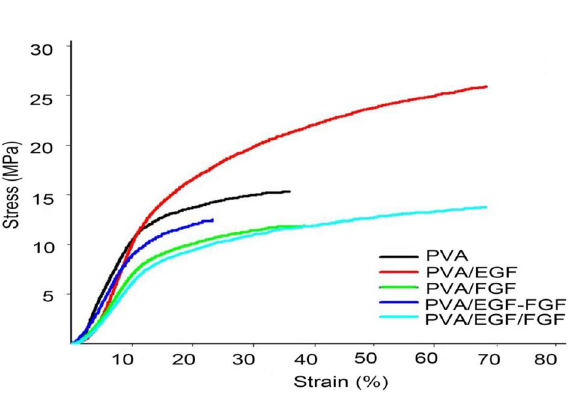
Figure 6. Stress–strain curves of ( a ) PVA, ( b ) PVA/EGF, ( c ) PVA/FGF, ( d ) PVA/EGF-FGF and ( e ) PVA/EGF/